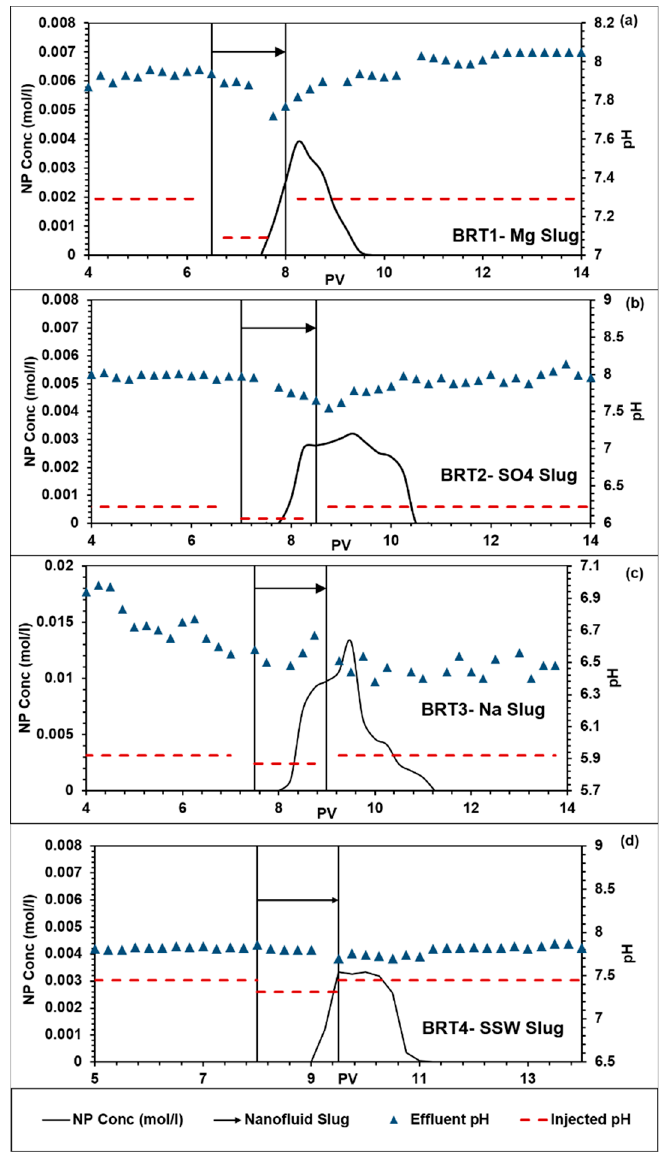
Figure 6. Effluent pH profiles for ( a ) BRT1; ( b ) BRT2; ( c ) BRT3; ( d ) BRT4. Figure 6. E ffl uent pH profiles for ( a ) BRT1; ( b ) BRT2; ( c ) BRT3; ( d ) BRT4. Nanomaterials 2019 , 9 , x FOR PEER REVIEW